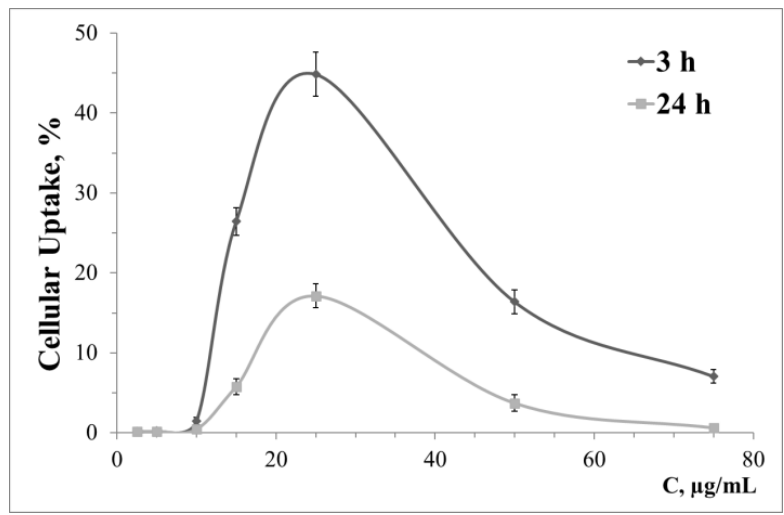
Figure 2. Cellular uptake of complexes with AuNP14 and siRNA (rndRNA-FAM, 100 nM) in HeLa cells after 3 and 24 h incubation. Data obtained based on fluorescence intensity from FAM-labeled RNA by flow cytometry.